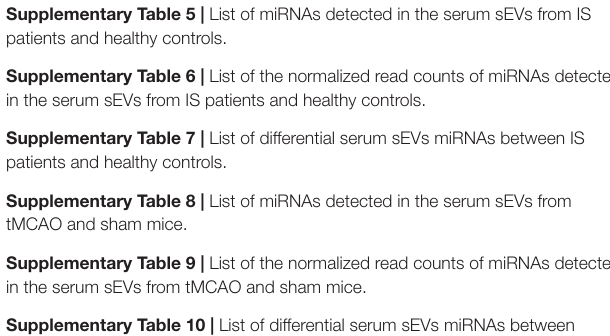
Supplementary Table 1 | Summary of small RNA-Seq analysis of human serum sEVs. Supplementary Table 2 | Summary of small RNA classification in human serum sEVs. Supplementary Table 3 | Summary of small RNA-Seq analysis of mouse sEVs. Supplementary Table 4 | Summary of small RNA classification in mouse